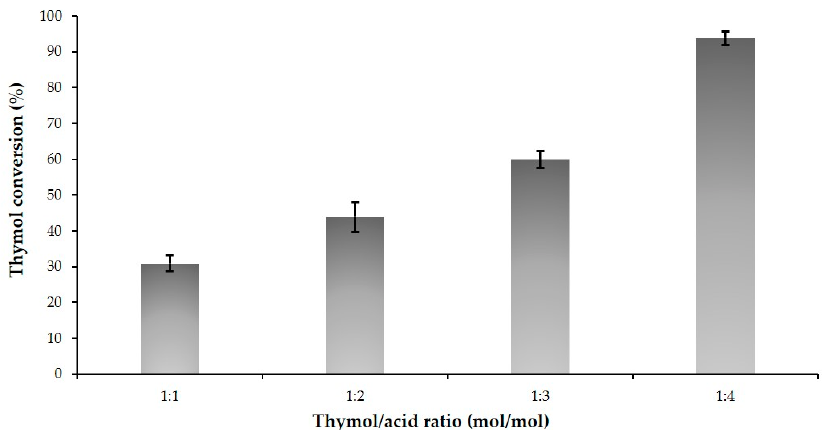
Figure 5. Change of the conversion of thymol as a function of the molar ratio of substrates. Reaction conditions: 2 mmol of octanoic acid, 200 µ L of CALB solution (50.5 mg mL − 1 of protein), 50 ◦ C, 24 h, conditions: 2 mmol of octanoic acid, 200 µL of CALB solution (50.5 mg mL − 1 of protein), 50 °C, 24 h, and magnetic stirring at 200 and magnetic stirring at 200 rpm.